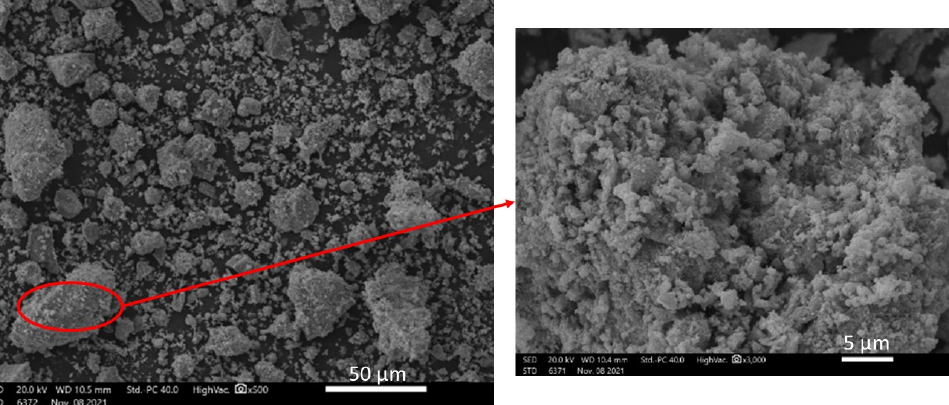
20–30 μ m. The specific area of all specimens was between 4–5 m 2 g − 1 . Figure 3. Typical scanning electron microscope photo of the morphology of all synthesized perovskite samples.